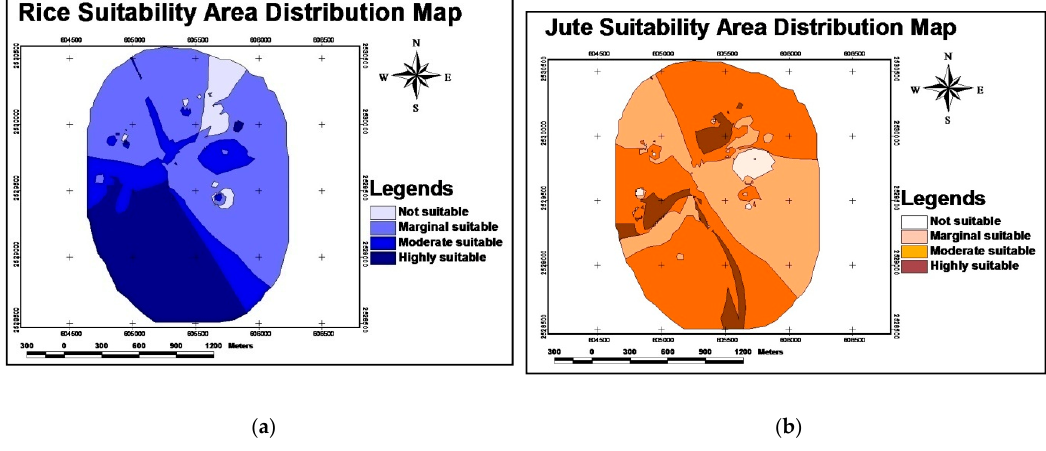
Figure 4. Kharif crops suitability distribution maps; ( a ) rice, ( b ) jute. Table 8. Pair wise comparison matrix and eigenvector of criteria in AHP for lentil crop ( n = 8).